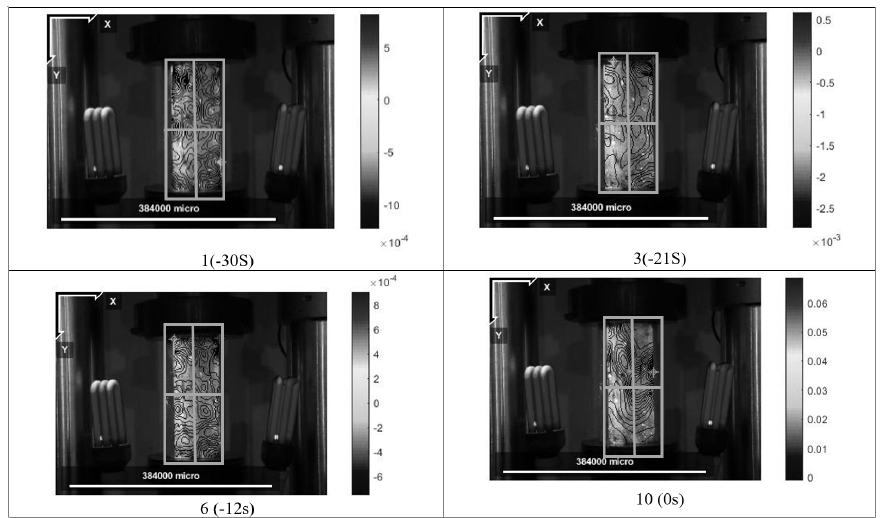
Frame 1 - Isoline map of deformations along the x-axis.